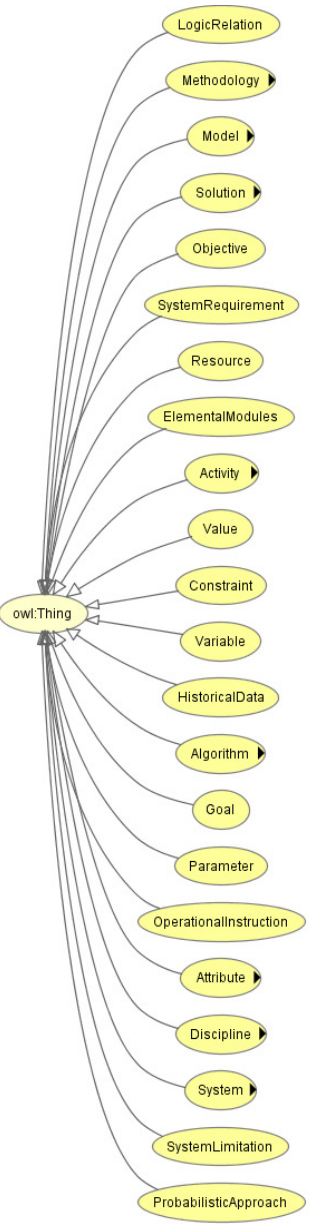
Figure 11. First taxonomical layer representation of the Operations Research Ontology